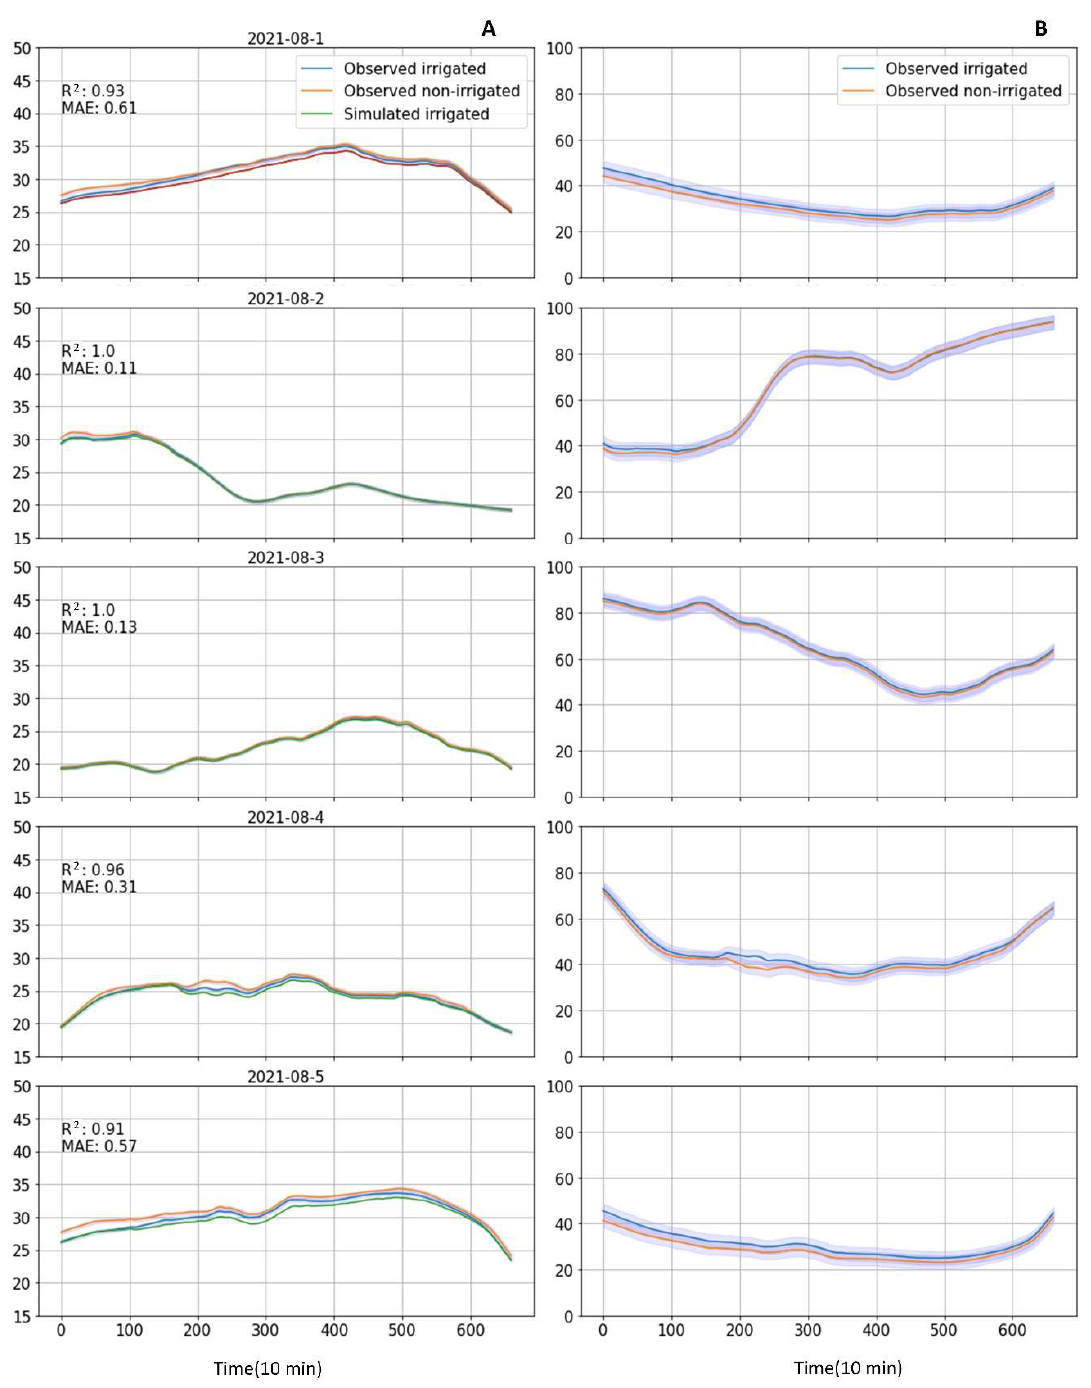
Figure 4. The air temperature ( A) and relative air humidity ( B ) at a ten-minute resolution between 10:00 and 21:00 above the canopy during the days between the first and second irrigation rounds.